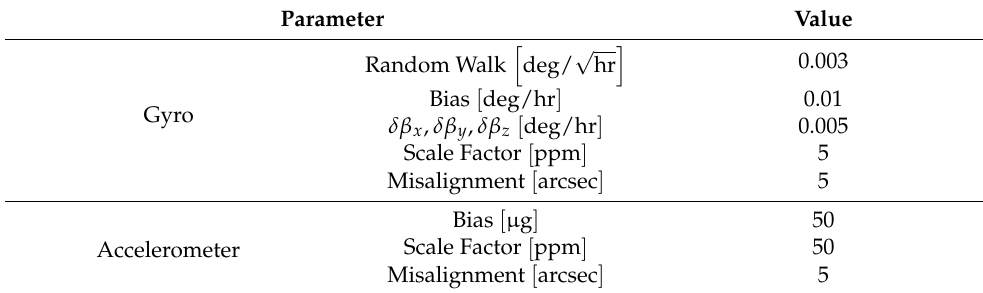
Table 3. Sensor specification for